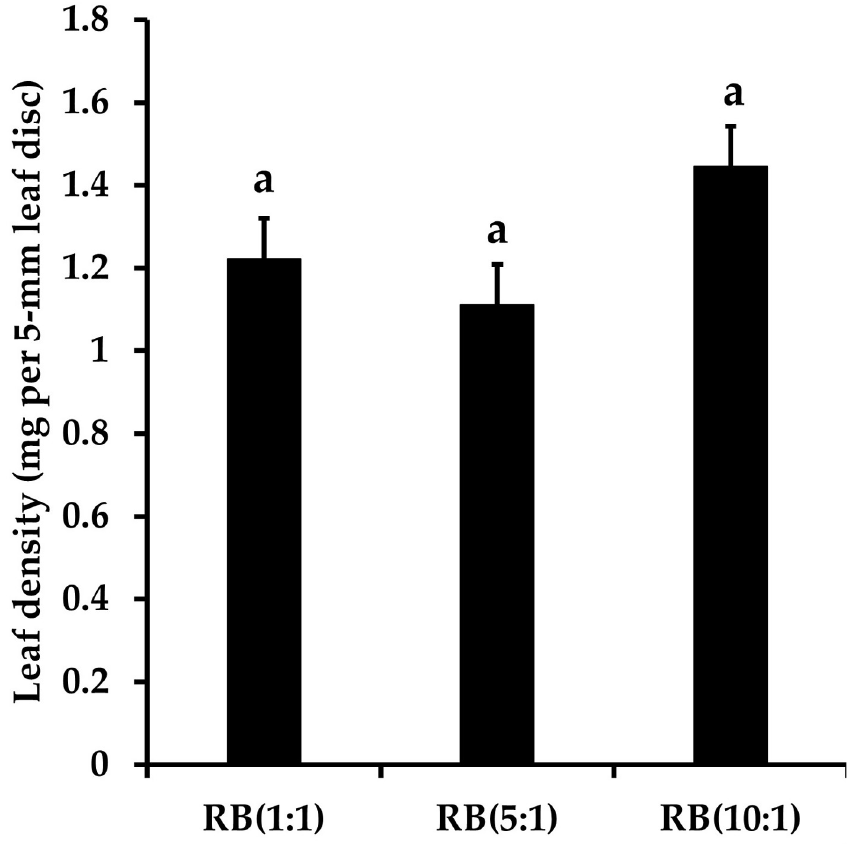
Fig 4. Leaf density (mg per 5-mm diameter leaf disc) measured by dry biomass of a leaf disc of Eutrema japonicum under each light treatment condition. RB indicates ratio of red and blue mixed